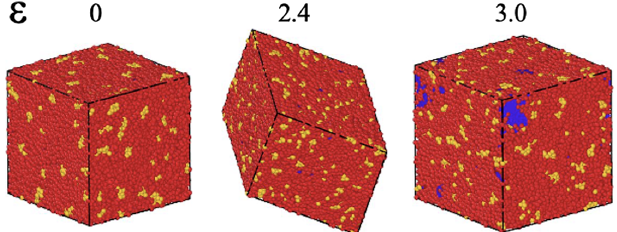
FIG. 3. Snapshots of systems with interaction ratio α ¼ 10 with cavities for Wi ¼ 4 at strain ε ¼ 0 , 2.4 (maximum stress) and ε ¼ 3 . Nonassociating beads, stickers, and cavities are visualized by red, yellow, and blue colors, respectively.